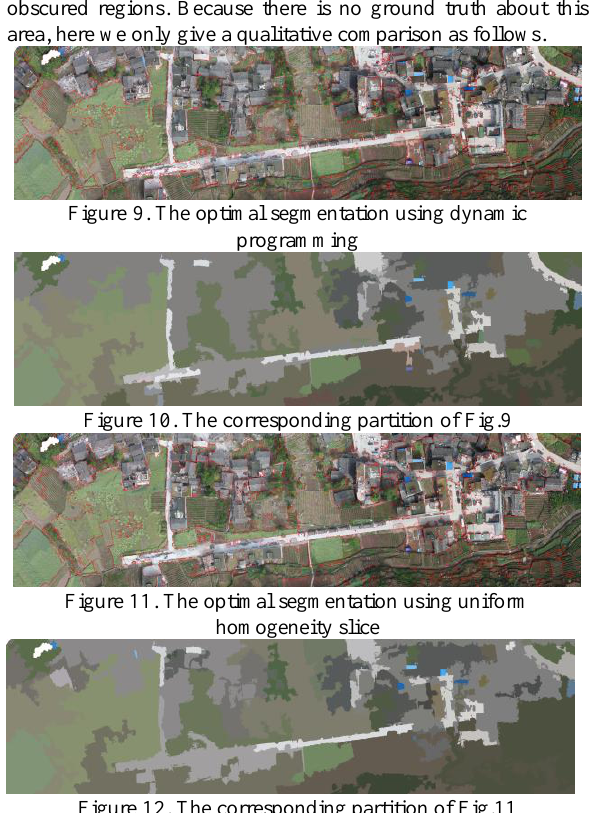
Figure 12. The corresponding partition of Fig.11